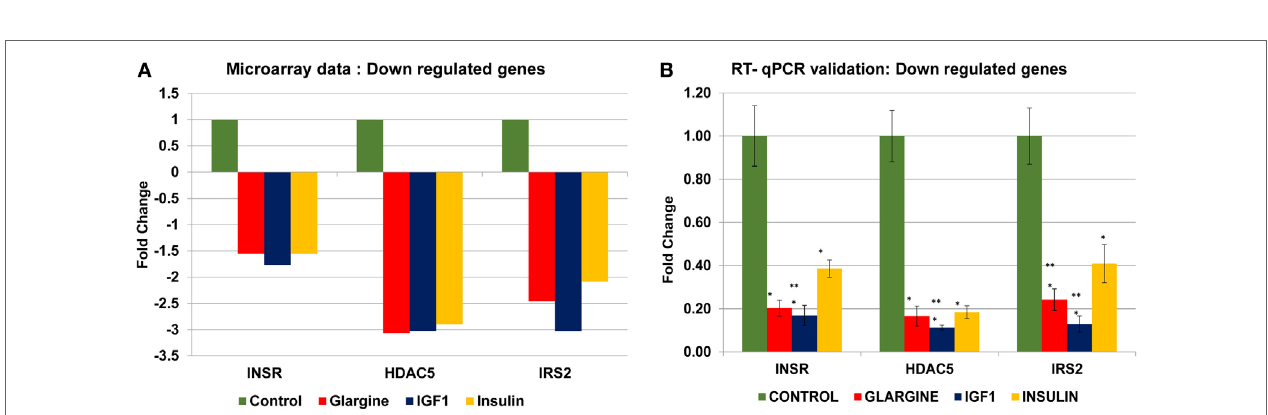
FigUre 9 | Real-time quantitative polymerase chain reactions (RT-qPCR) validation of the microarray data for selected downregulated genes in USPC-1 cells. (a) Microarray results of four selected downregulated genes; (b) relative expression of the downregulated genes by RT-qPCR. Lower values were obtained in the RT-qPCR validation compared to values obtained in the microarray assay. RT-qPCR was done in triplicate and the ratio was calculated relative to actin. * p < 0.05 insulin analogs vs. untreated cells; ** p < 0.05 ligand vs. regular insulin. The y -axis represents fold